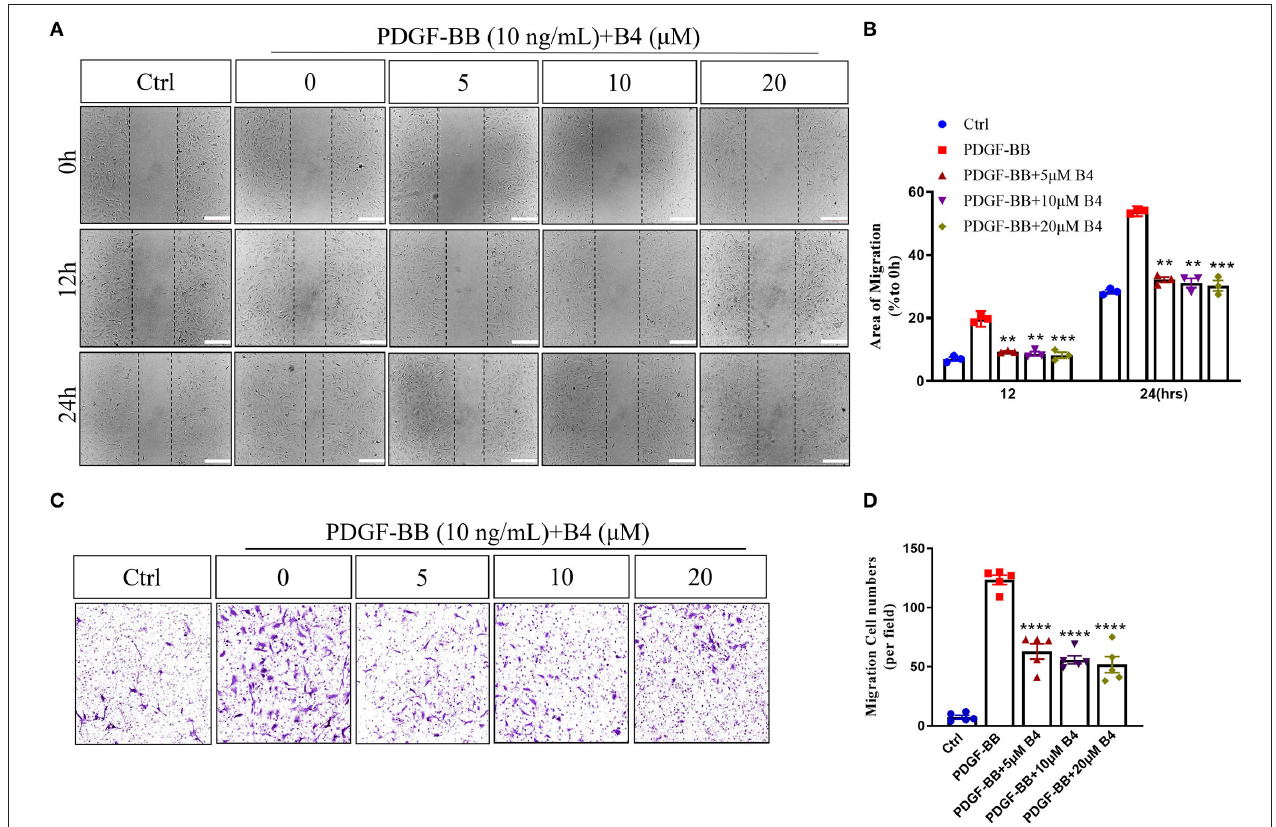
FIGURE 3 | B4 prevents MVSMCs migration. (A) Representative images of quiescent MVSMCs were pretreated with B4 for 24h and stimulated with PDGF-BB for 24h. Images were captured at 0, 12, 24h. The percentage of area covered by migrated cells over time was calculated using ImageJ (B) . N = 3. Scale bar, 200 µ m. (C) Representative images from transwell migration assay with different conditions. (D) Quantification for the number of migrated cells is shown in the bar graph. N = 5. All experiment was repeated at least three times. Data shown are means ± SEM. ** P < 0.01; *** P < 0.001; **** P < 0.0001 vs. PDGF-BB control group.